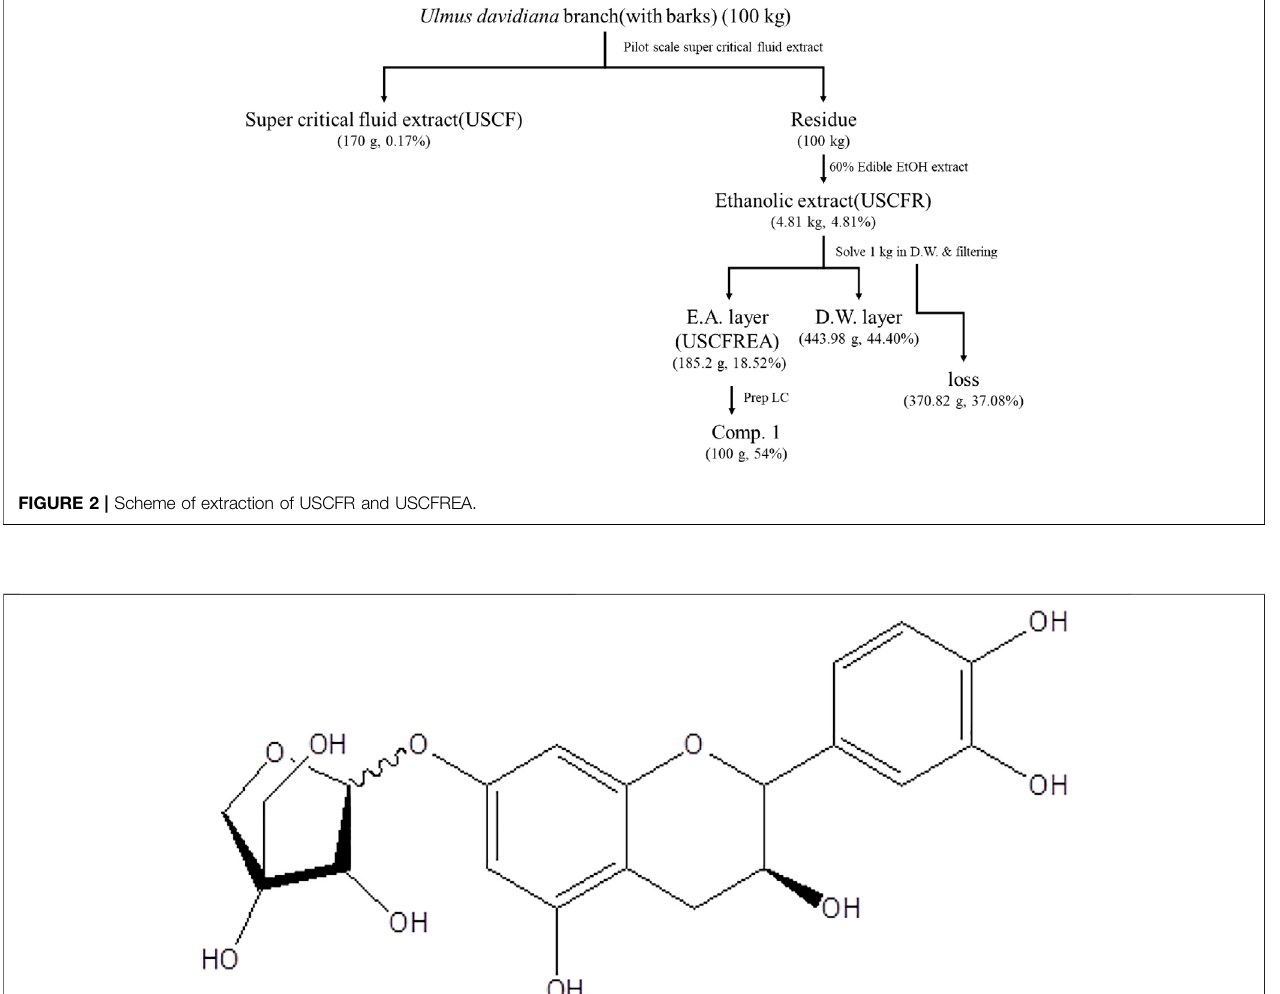
FIGURE 3 | Chemical structure of compound 1 isolated from Ulmus davidiana branch (with